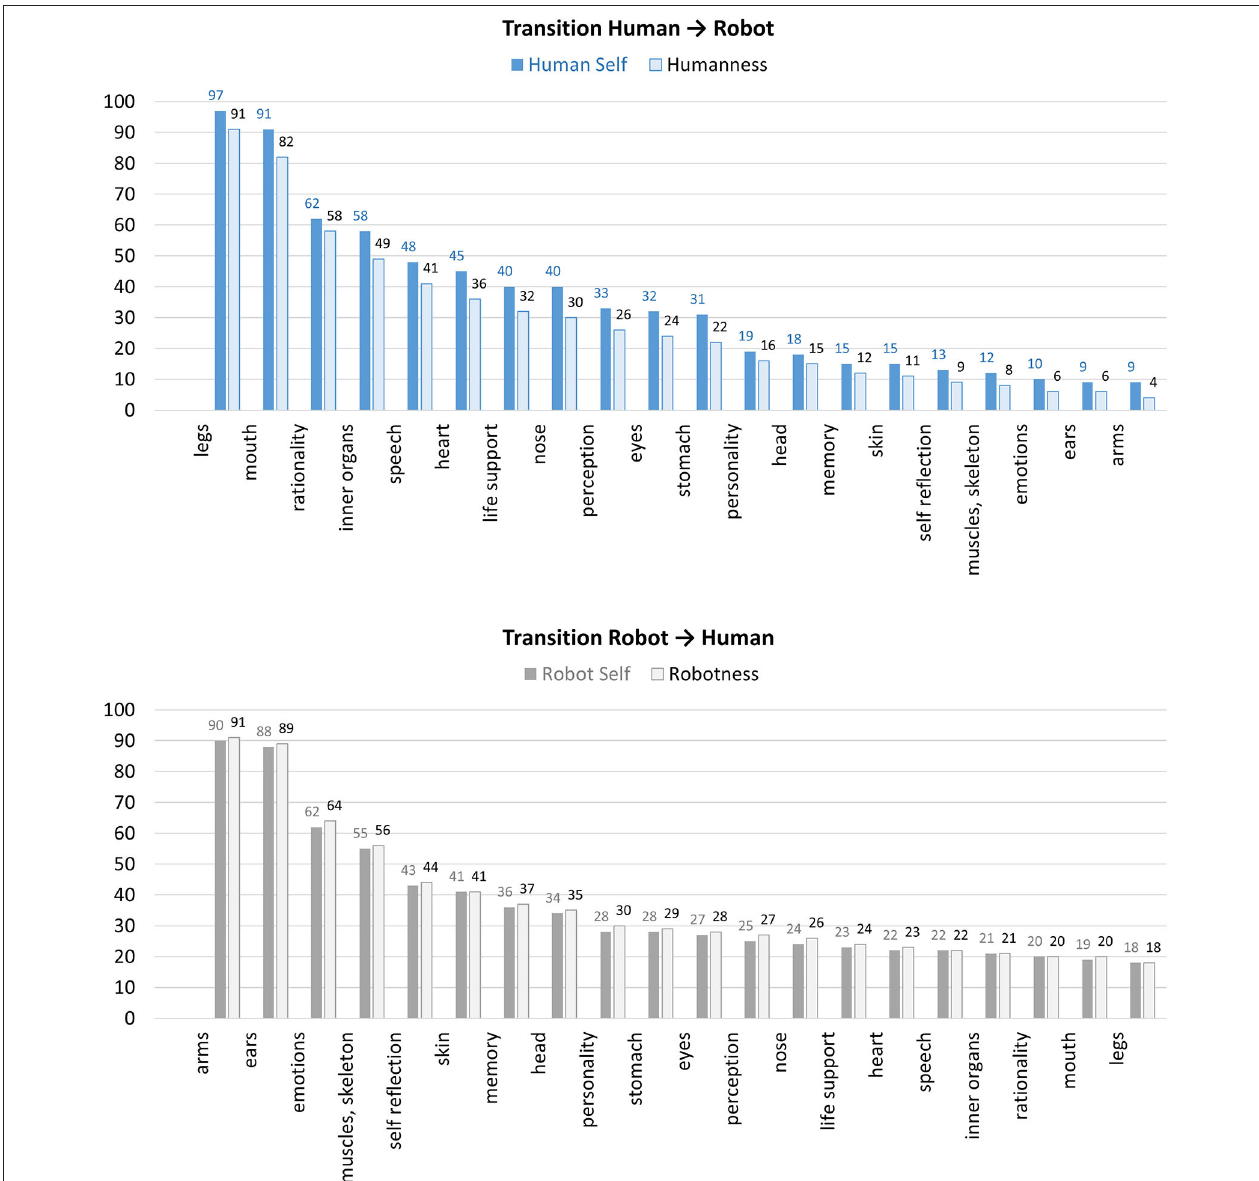
FIGURE 2 | The participants’ ratings of the remaining ratio of self and humanness in the human-to-robot condition (top) and ratings of the remaining ratio of self and robotness in the robot-to-human condition (bottom) at different points of transition.